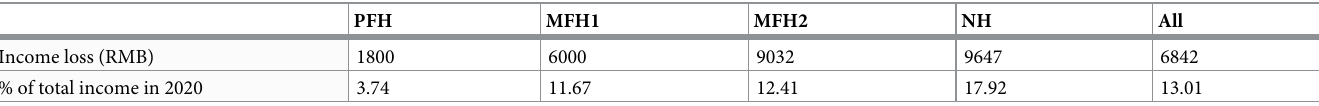
Table 2. Income loss of different rural